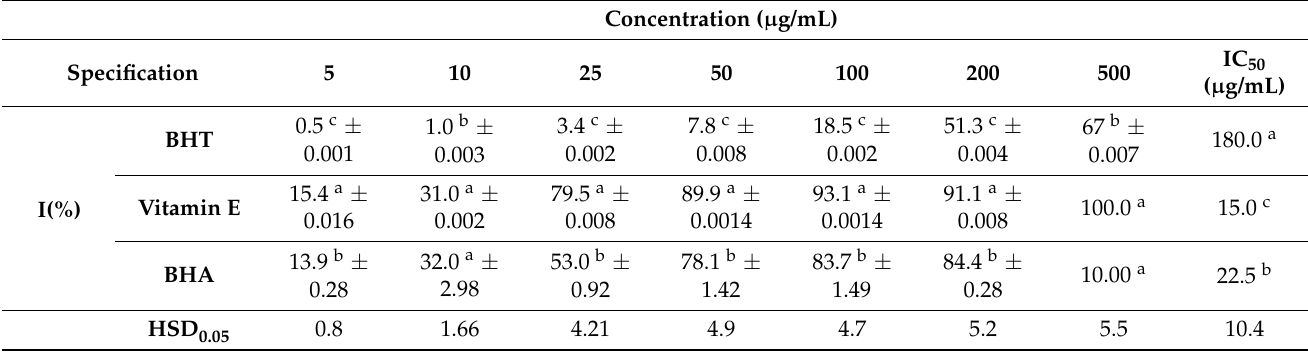
Letter indicators at averages determine the so-called homogeneous groups (statistically homogeneous). Table 7. Descriptive statistics of the DPPH radical scavenging activity of the standard solution (experiment with leaves).